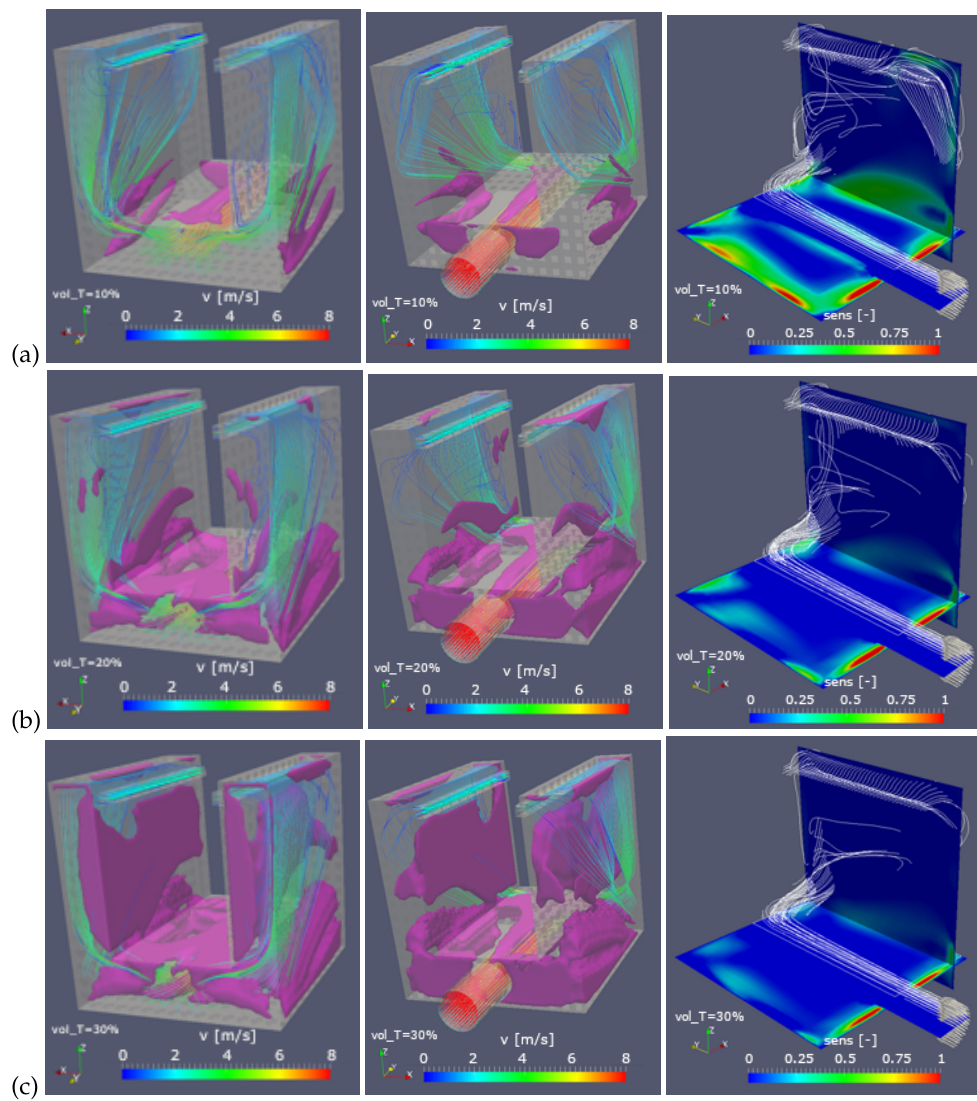
Figure 7. Flow pattern (streamlines) and α distribution (left–back view, middle–front view) and sensitivity (right) for 3D flow distribution duct optimization with vot T = 10% ( a ), 20% ( b ), 30% ( c ).